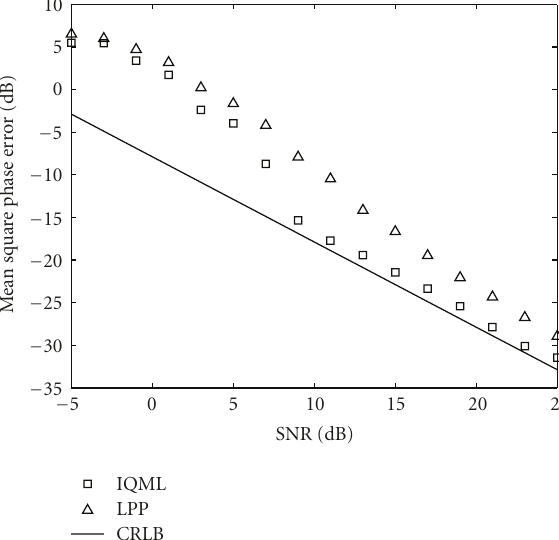
Figure 21: MSE for φ 2 of multiple complex